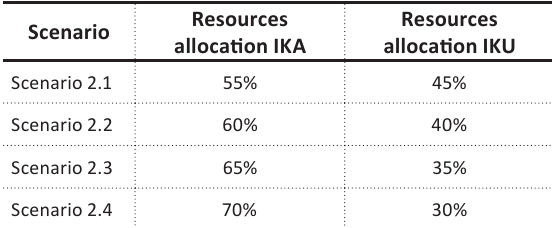
Table 4. Total of IKA and IKU revenue from